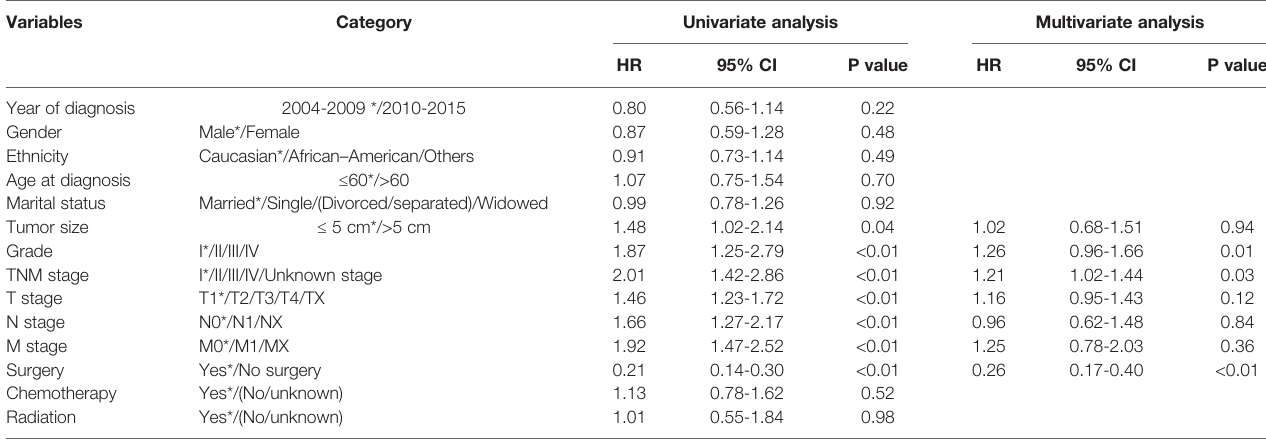
TABLE 2 | Univariate analysis and multivariate analysis of factors of overall survival (OS) of combined hepatocellular carcinoma and cholangiocarcinoma.